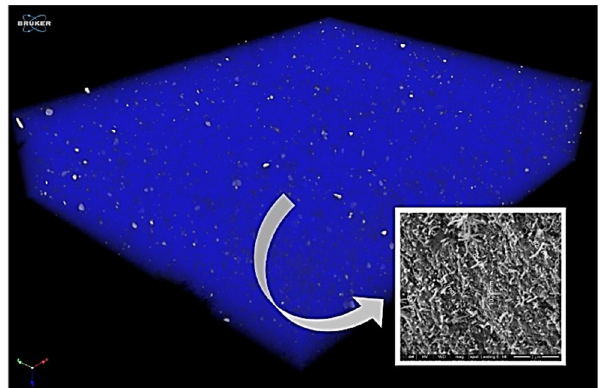
Figure 2. Micro-computed tomography image of carbon nanotube (CNT)-modified epoxy composite. The inset presents the CNT agglomerates.